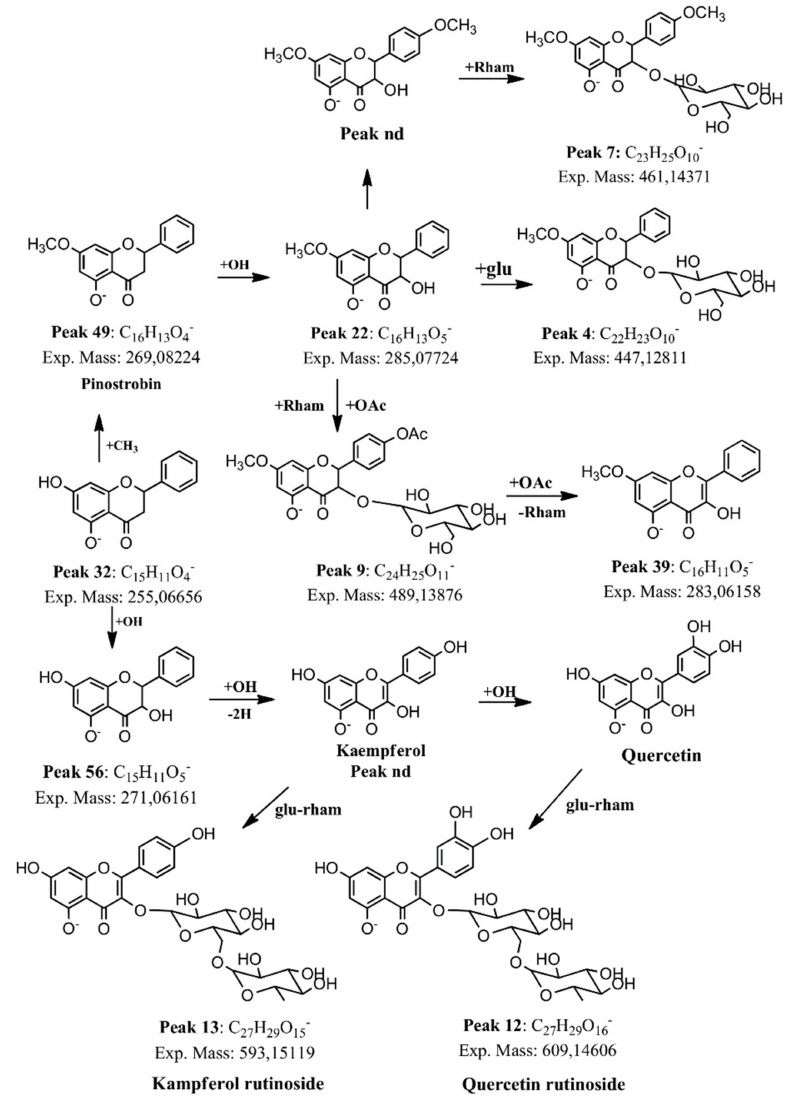
Figure 4. Biosynthetic relationship among flavonoids detected in N. ramosissima